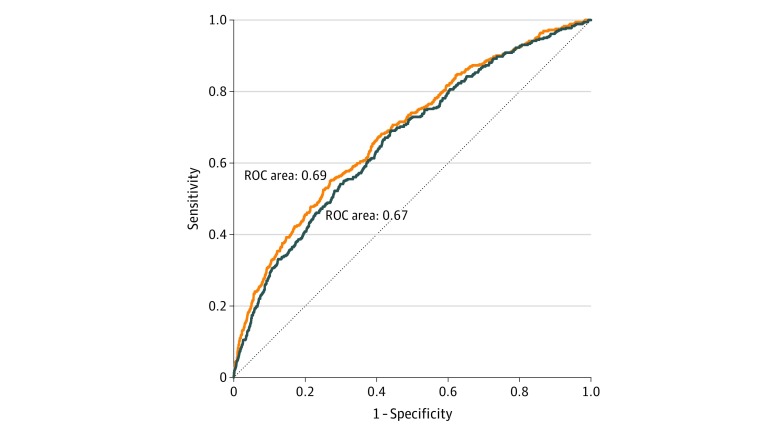
Receiver Operating Characteristic (ROC) Curves for Prediction of All-Cause DeathA comparison of the model including the Framingham Risk Score (blue curve) with the model including the Framingham Risk Score and estimated pulse wave velocity (orange curve).